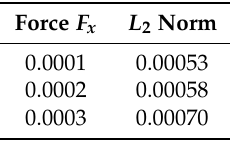
Figure 4. Velocity profiles for different values of the x component of the force F x —transversal section of the channel. Table 2. L 2 norm for different value of the force F x —Forces expressed in